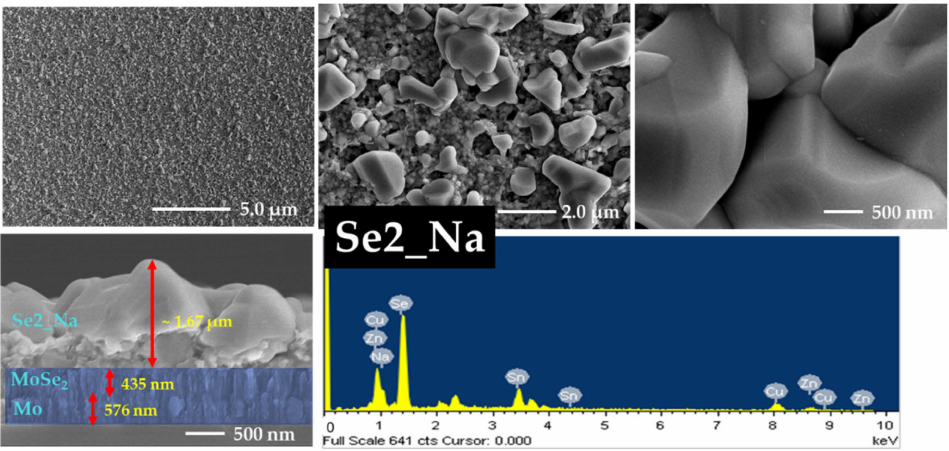
Figure 8. Surface and cross-section images and EDS spectra of Se2_Na thin film with sodium